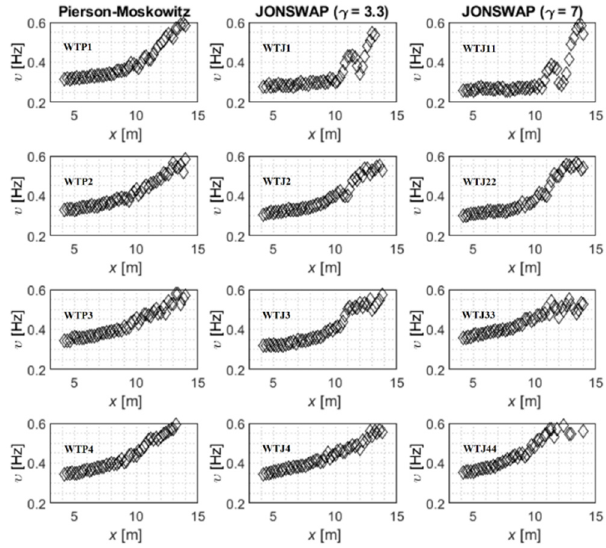
Figure 2. The spatial evolution of the spectral broadening 𝜐 . Skewness, λ 3 (Equation (4)), is a statistical parameter that is contributed to primarily by the second-order nonlinear interactions between bound waves, and kurtosis, λ 4 (Equation (5)), is a statistical parameter that includes a dynamic component due to the third-order interactions between wave components. The latter parameter indicates whether the probability density of a surface elevation’s peak is higher or lower than that of a typical Gaussian distribution [25]. The kurtosis increase may indicate the formation of extreme waves [26]. In other words, kurtosis measures the weight of the peak relative to the rest of the distribution. In the case of a Gaussian sea state, λ 3 = 0 and λ 4 = 0 are normally expected. However, for a non-Gaussian sea state, λ 3 > 0 is related to sharper crests and troughs, whereas λ 3 < 0 is related to wider crests and troughs. Moreover, λ 4 > 0 is related to an increased probability of the occurrence of extreme waves. In this paper, excess kurtosis (Equation (5)) is used instead of kurtosis [36].